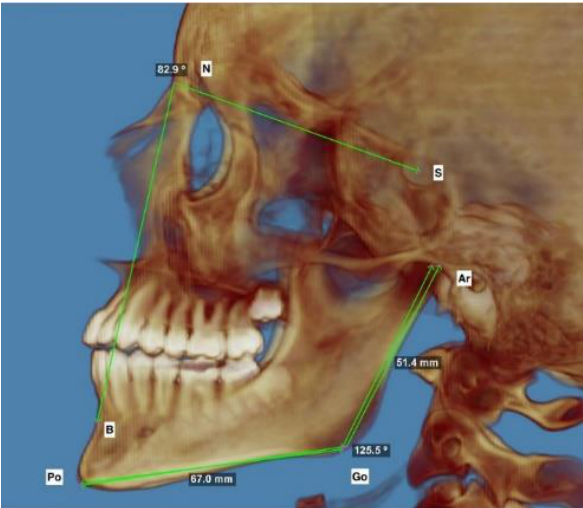
Figure 3. Representative lateral photograph of 3D imaging of the reference points used for the measurements described in the Table 2. The auricular (Ar) – gonion (Go) sections were used to measure changes in height of the mandible ramus; the gonion (Go) – pogonion (Po) sections were used to measure changes in the length of the mandible body. The SNB angle was used to measure the anterior growth of the mandible.